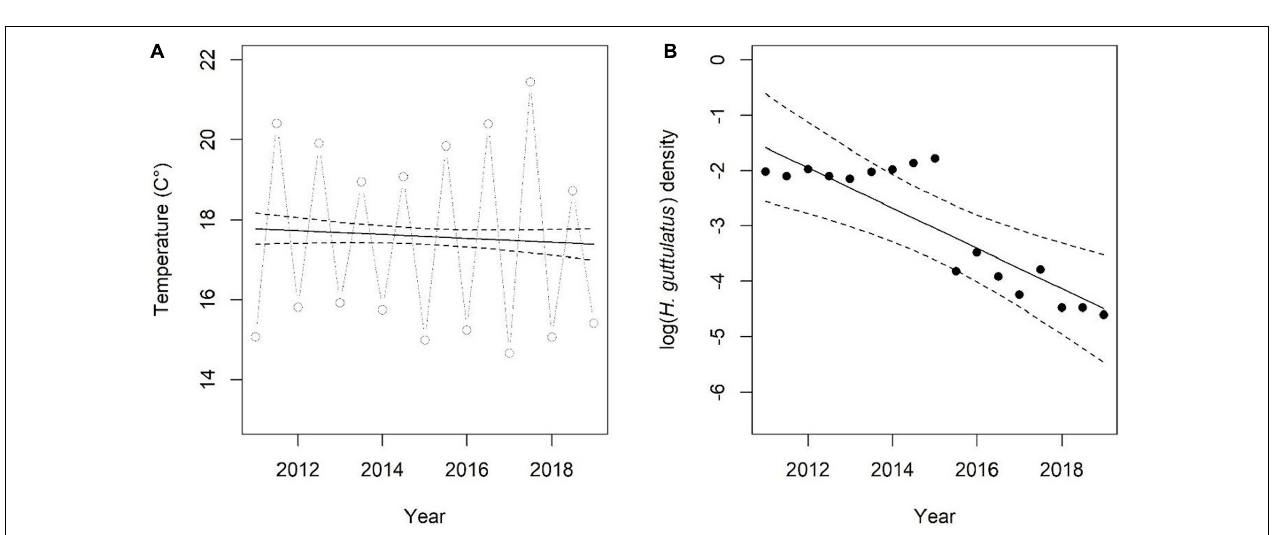
FIGURE 2 | Average density values ( ± s.d.) of H. guttulatus from Autumn 2011 to Autumn 2019. In blue, surveys carried out at Site 1 (No control). In red, surveys carried out at Site 2 (Light control).